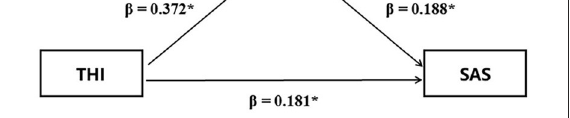
FIGURE1 Simple mediation model for the relationship between anxiety as measured via the SAS and tinnitus severity as measured via the THI. THI, Tinnitus Handicap Inventory; SAS, Self-rating Anxiety Scale; PSQI, Pittsburgh Sleep Quality Index; β , regression coefficient; * , p <